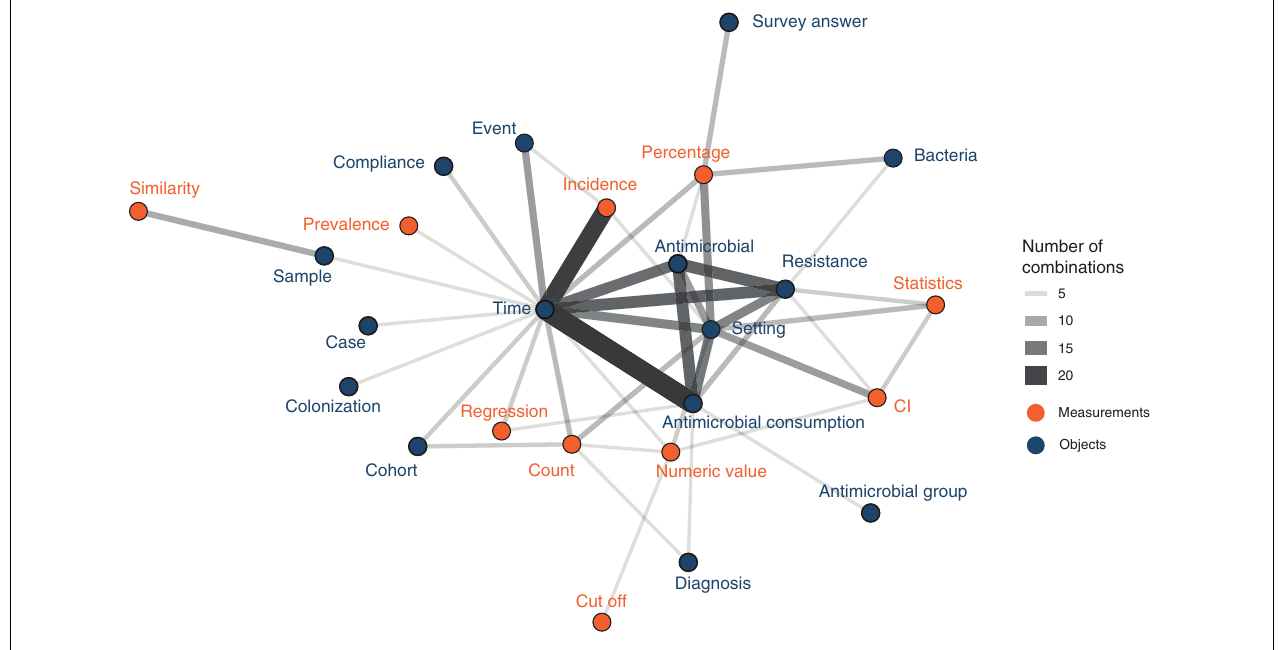
FIGURE 3 | Attribute combinations in visualizations (combination count ≥ 3), thickness of lines corresponds to combination count. Orange points and labels represent attributes related to measurements; blue points and labels represent attributes related to objects.